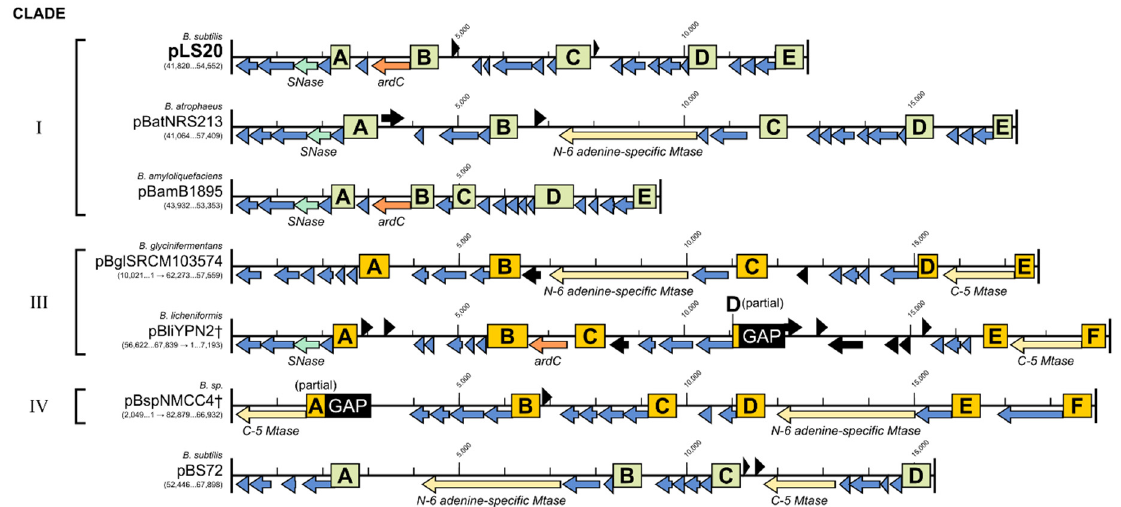
Figure 7. Putative establishment regulons present on plasmid pBS72 and on the pLS20 family reference plasmids of clades I, III, and IV. EGeRS1 regions are boxed and labelled with letters (A to D/F). Green and yellow-coloured boxes are used to indicate EGeRS1 sequences that belong to the same phylogenetic clade (see Figure 4). In each plasmid, the EGeRS1 sequences precede putative operons of two to six genes. Genes controlled by EGeRS1 sequences are shown in blue, except the homologues of gene ardC (highlighted in orange), genes encoding putative MTases (highlighted in yellow), and homologue genes for SNase (in light green). Black arrows indicate genes that are not controlled by EGeRS2 sequences.